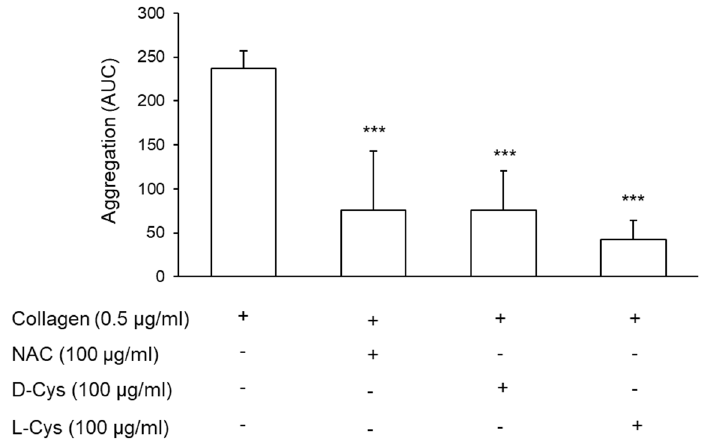
Figure 5 . Effect of D- and L-Cys on platelet aggregation. PRP was incubated with NAC, D-Cys, or L-Cys for 30 min at 37 °C. Platelet aggregation was induced by the addition of collagen and monitored for 6 min, n = 4. *** p < 0.001 vs. collagen-stimulated PRP, for ANOVA and Dunnett’s post hoc test.